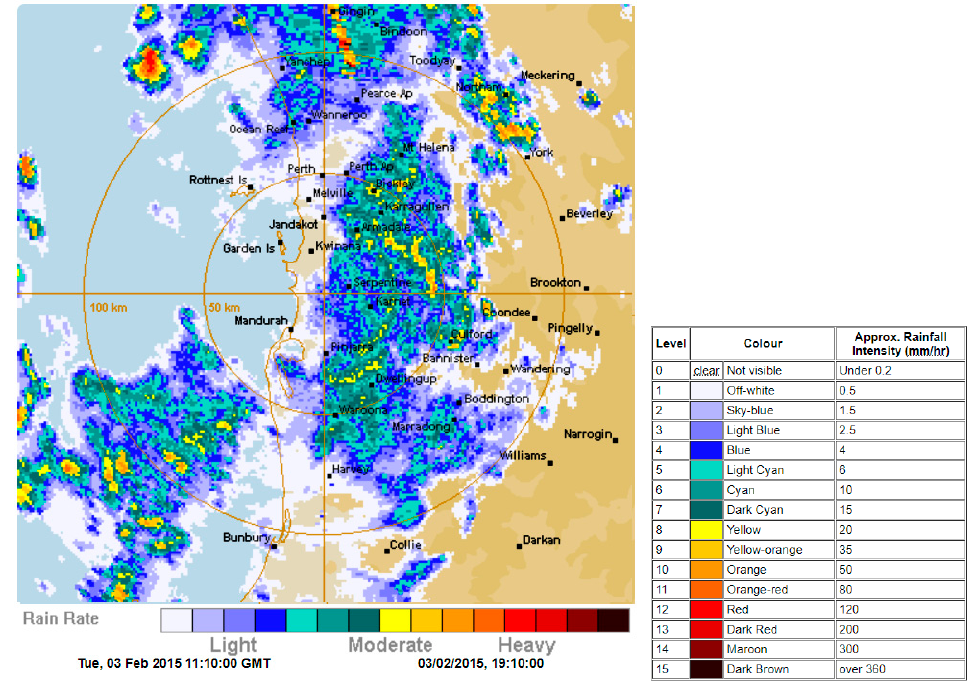
Figure 9. Rainfall radar map for min rainfall event over the Perth Hills in early February 2015 [18,41].